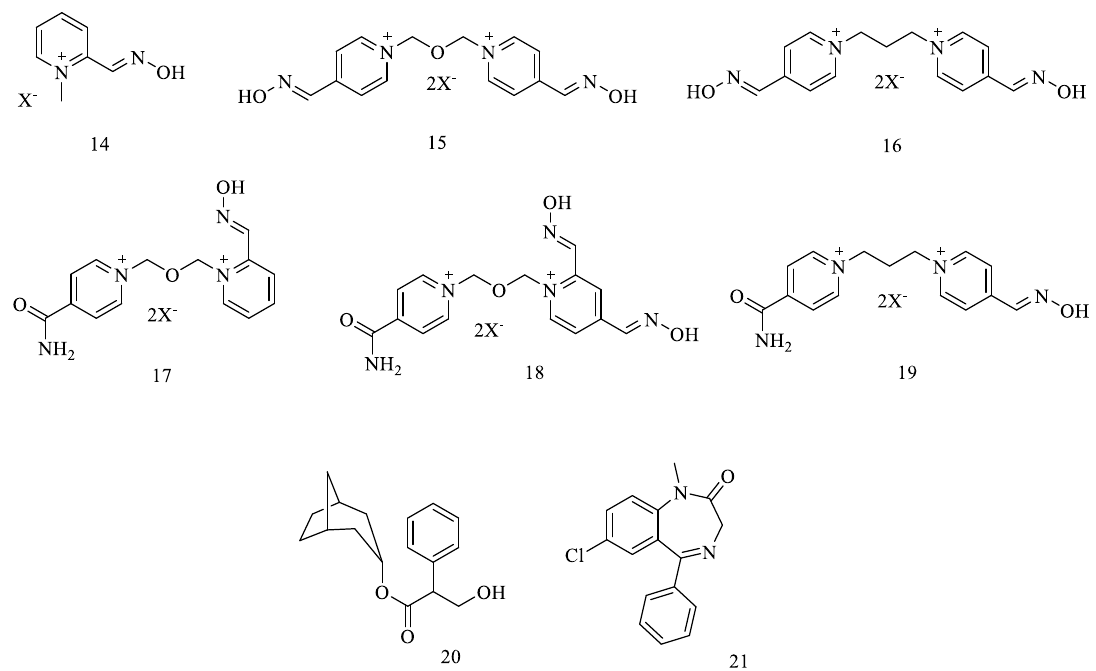
Figure 2. Structures of compounds used for organophosphate poisoning.